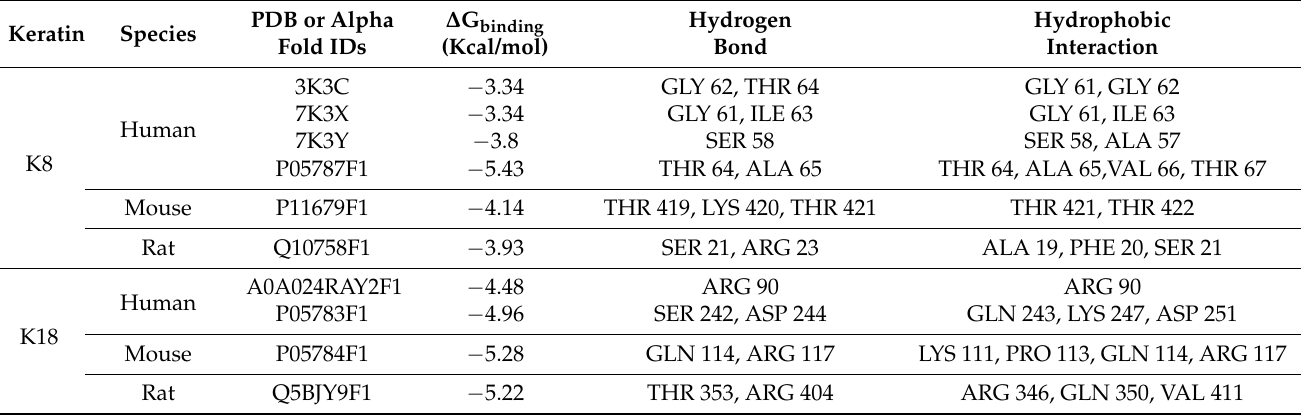
Table 3. Molecular docking details of 4-desmethylgriseofulvin (4-DMG) interaction with Keratin 8 (K8), and Keratin 18 (K18) in Human, Rat, and Mouse.